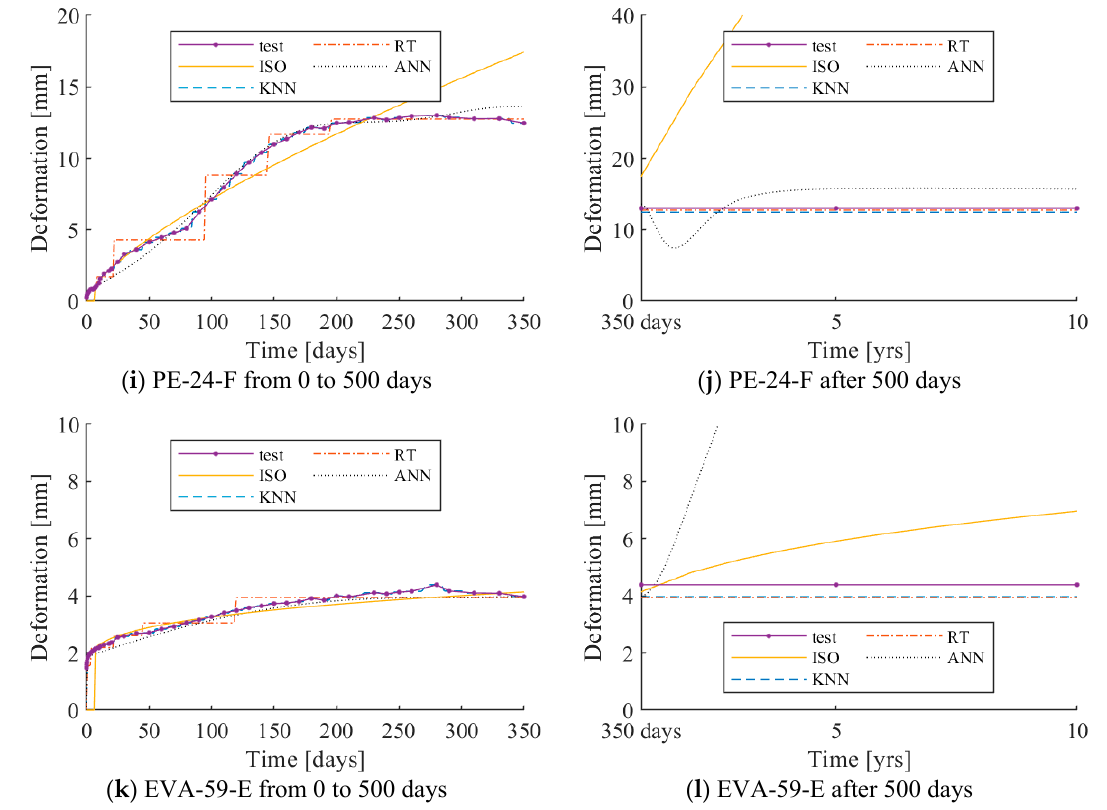
Figure A2. Long-term deformations as predicted by ISO 20392 (solid), KNN (dashed), RT (dash-dot), and ANN (dotted) compared to the experimental data under 80 N loading.